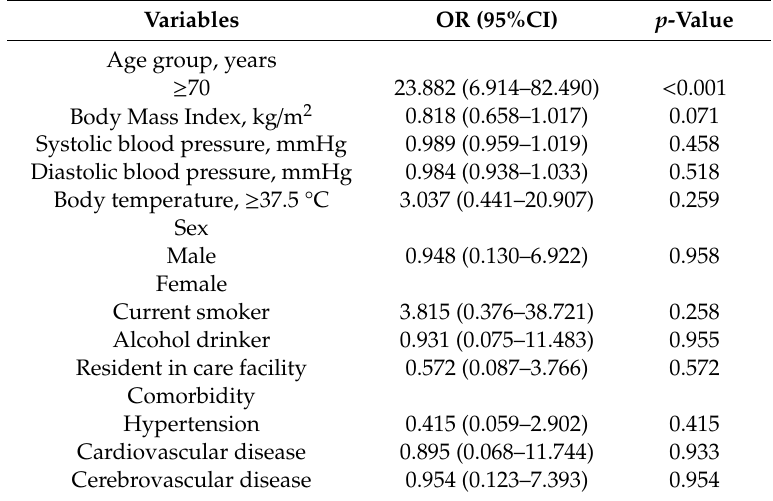
Table 3. Univariate regression analysis results for risk factors of mortality in COVID-19 patients with diabetes a